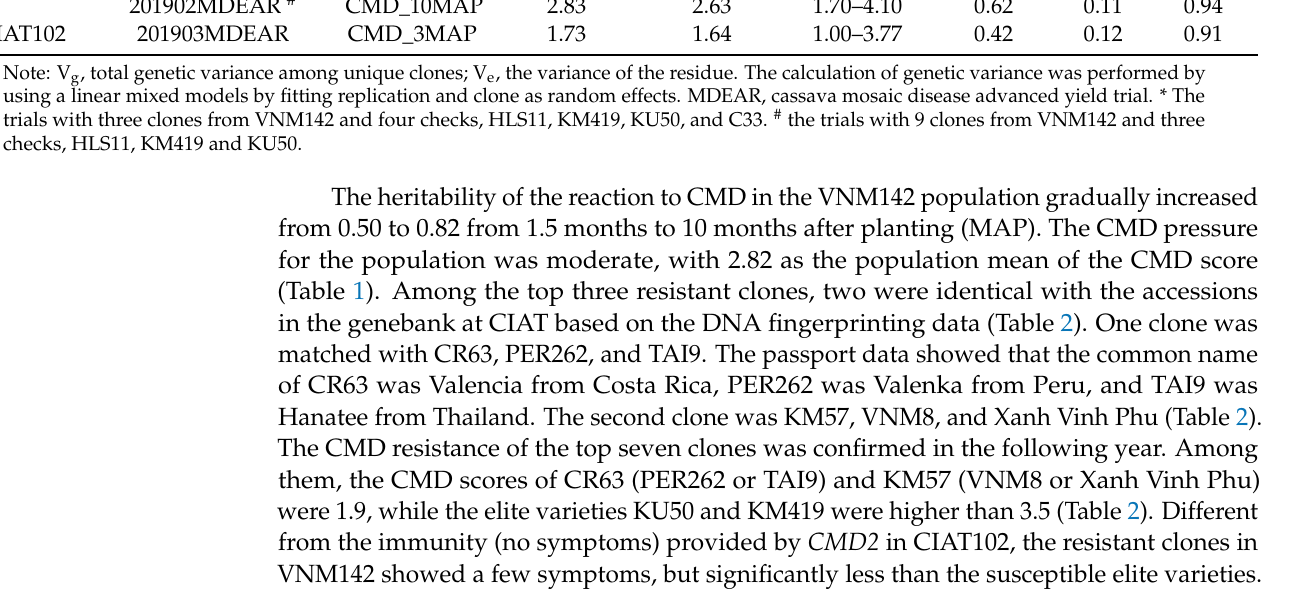
Table 2. The CMD score and genotype of the top resistant clones from VNM142 and the check clones.